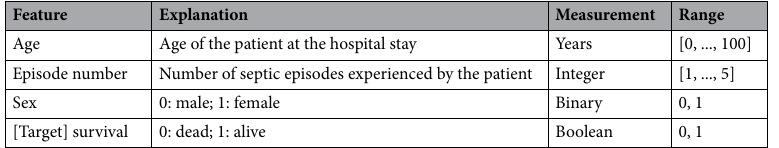
Table 1. Meanings, measurement units, and intervals of each feature of the dataset. Ranges refer both to the primary cohort and the study cohort. We used survival as prediction the target in this manuscript.